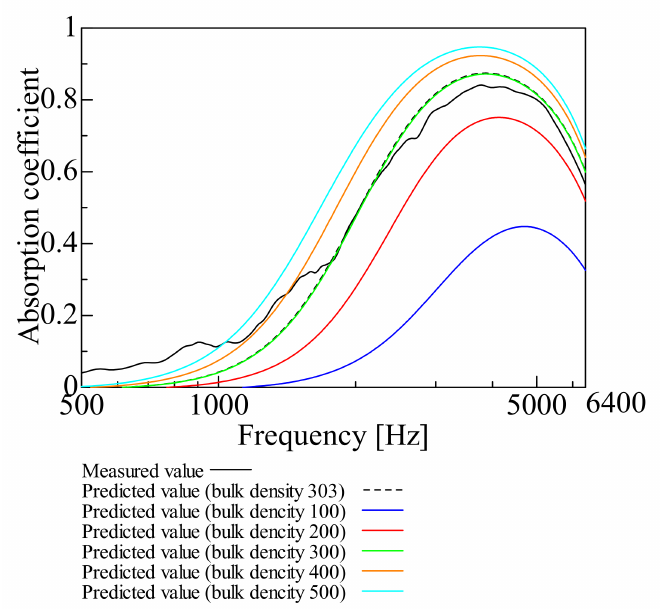
Figure 7. Variation of predicted value due to variation of bulk density: bulk density 100, 200, 300, 400, 500, and